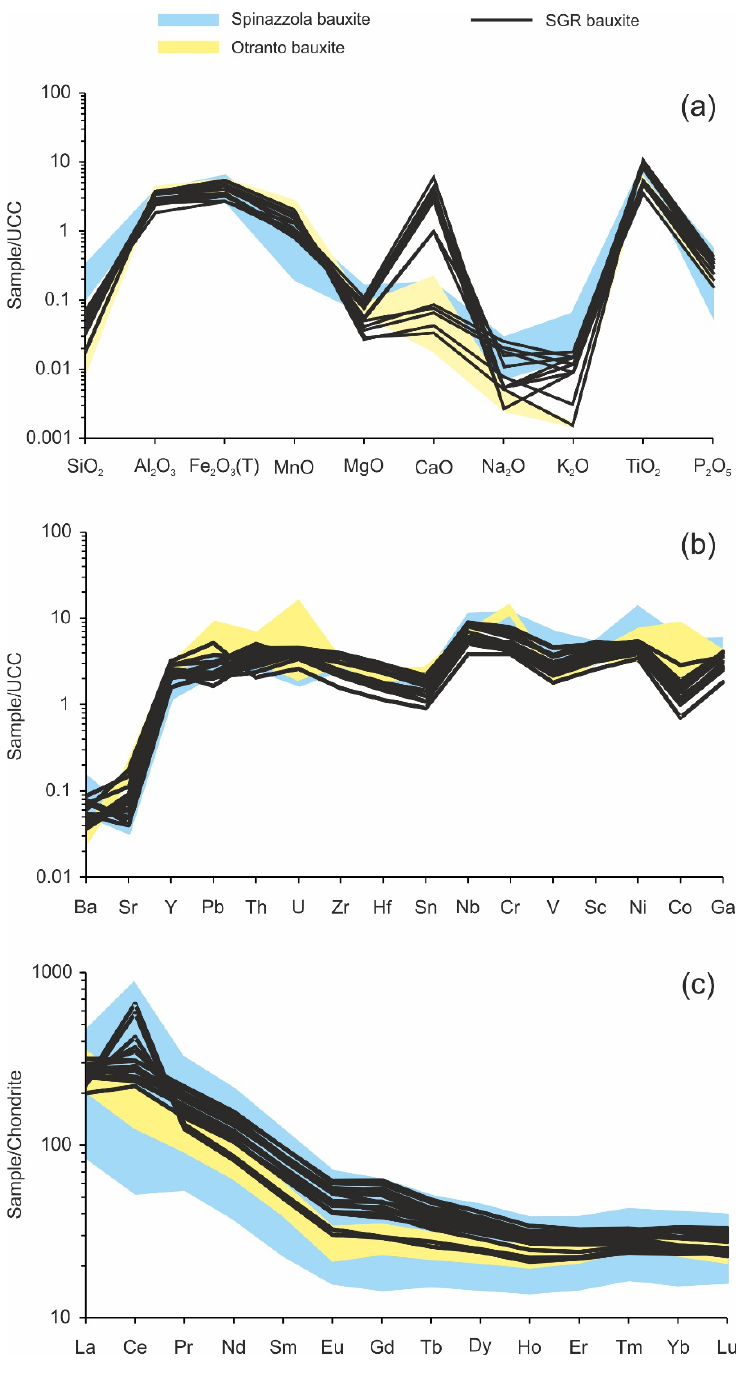
Figure 8. Major ( a ), trace ( b ), and rare earth elements (REEs), ( c ) normalization diagrams for the SGR samples. The compositional fields of bauxites from Spinazzola (Modified from Mongelli, et al. [16]) and Otranto (Modified from Mongelli, et al. [3]) are also displayed for comparison. See text for further details.